Question: What style of plot is this figure drawn as?
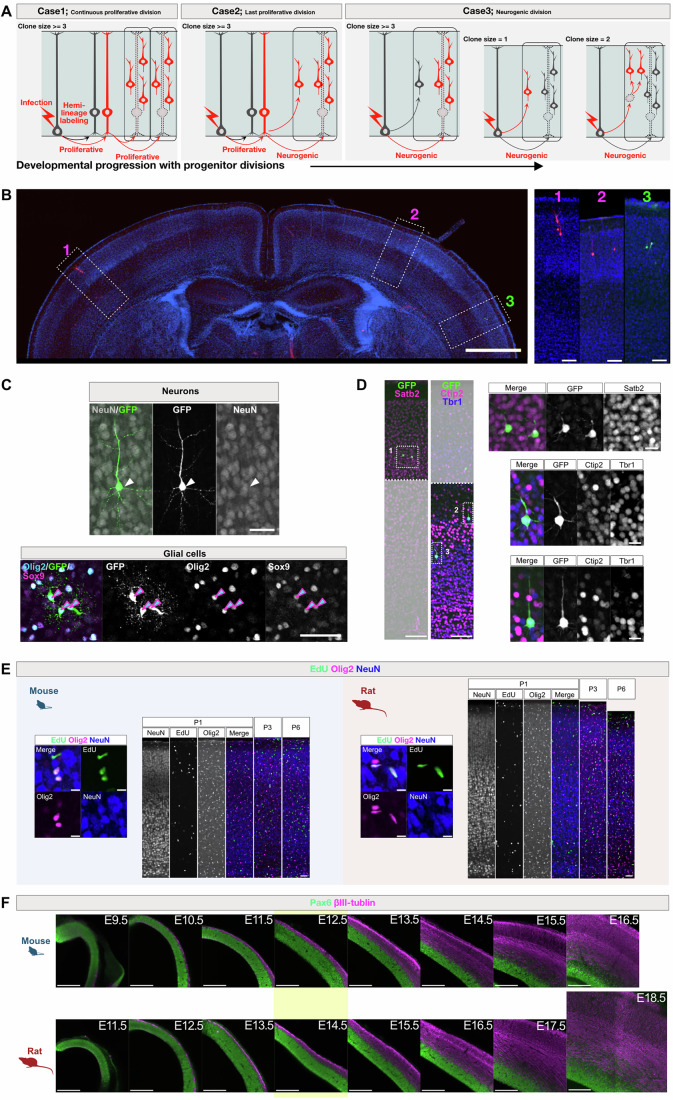
Answer: bar